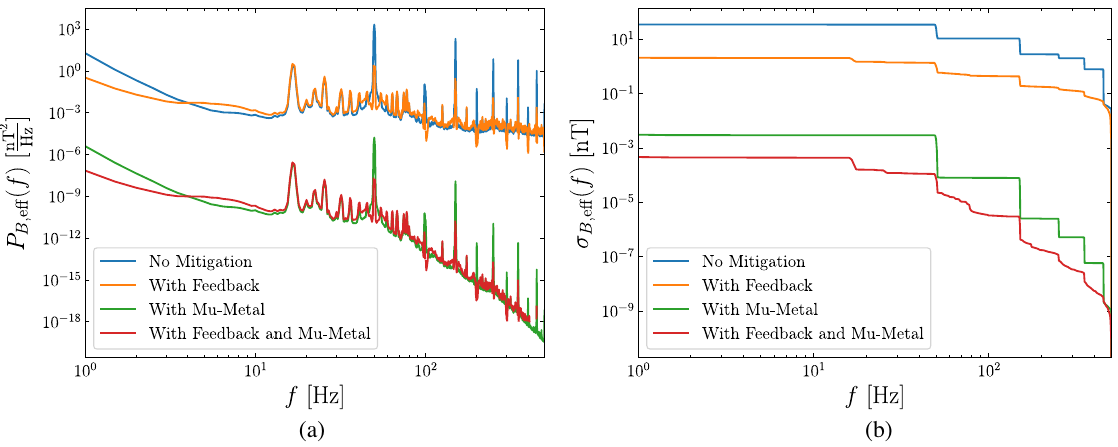
f Þ vs frequency f and (b) standard deviation σ FIG. 11. (a) Effective stray field PSD P B; eff ð (blue); including a beam-based feedback system (orange); including a 1 mm mu-metal shield (green); and with the feedback system and mu-metal shield combined